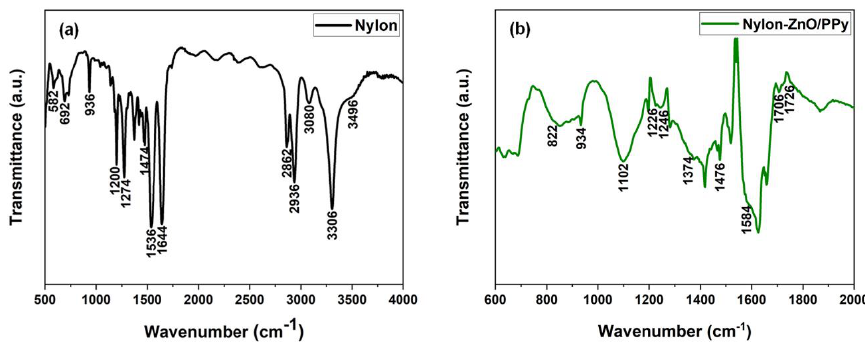
Figure 3. FTIR spectra of ( a ) as spun nanofibers and ( b ) PPy/ZnO coated meshes.